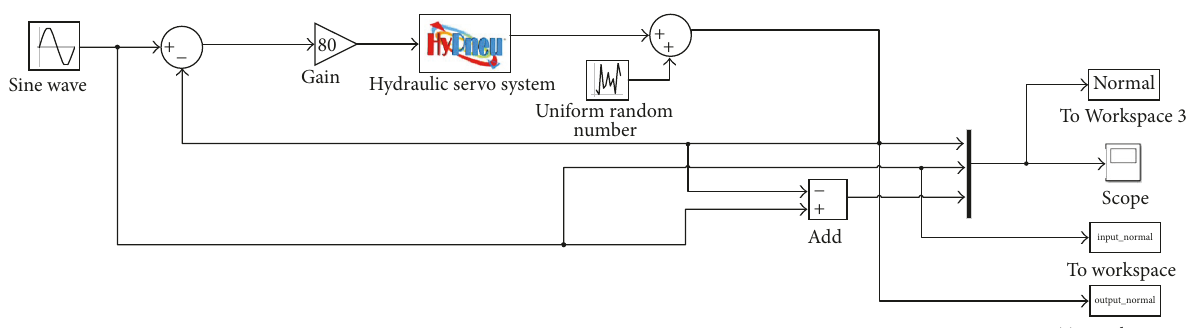
Figure 3: The failure injection model of dynamic control part using